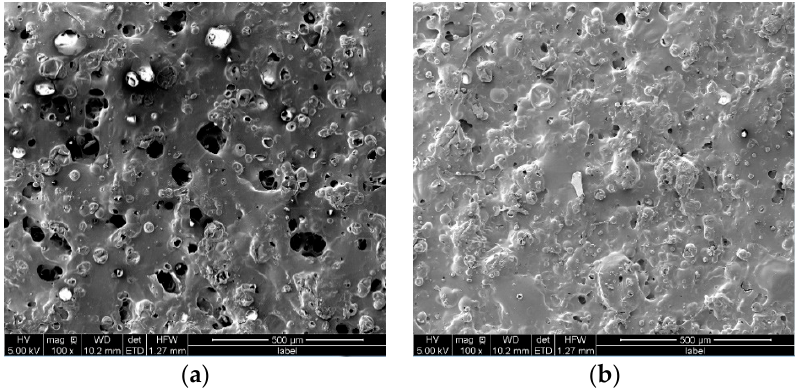
Figure 1. SEM images of coatings fabricated using 5% PAA ( a ) and 8% PAA ( b ).